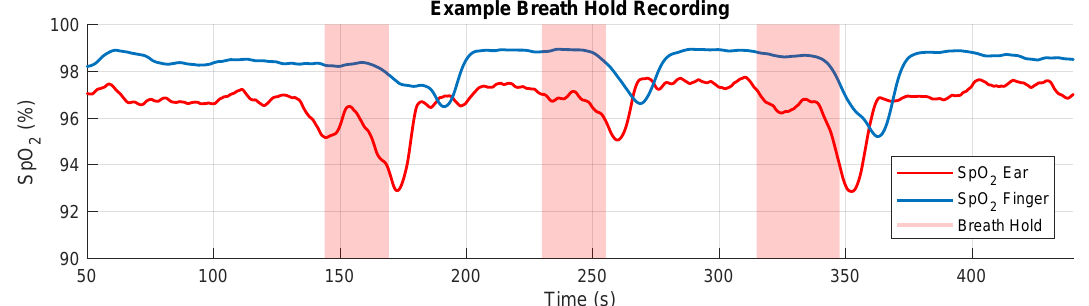
Figure 5. Exemplar SpO 2 recording following the breath hold protocol (see Figure 3). The breath holds (starting with the exhale and finishing at the end of the breath hold) are designated with the shaded regions. The SpO 2 recorded from the right index finger is denoted by the solid blue line, and the SpO 2 recorded from the right ear canal by the solid red line. The three significant drops in SpO 2 levels correspond to the three breath holds. The breath holds also vary slightly in length as they adhere to when the subject holds down a button rather than the set time of the instructional display, thus mirroring the true breath hold duration more